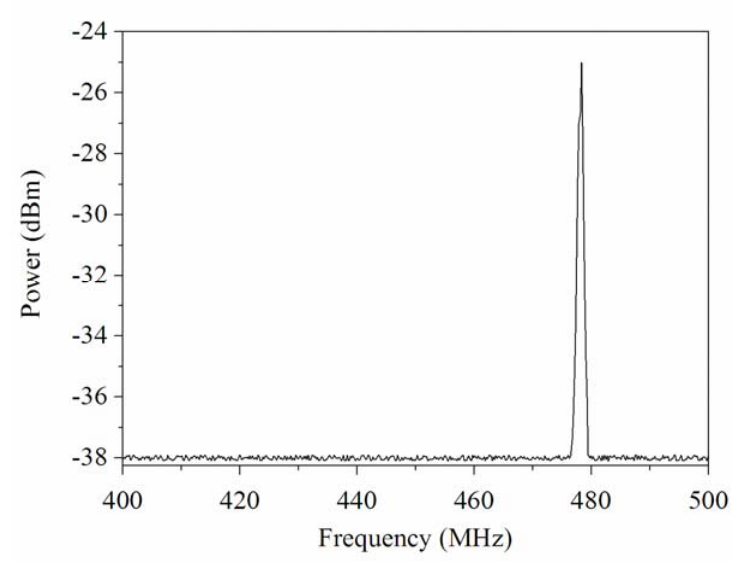
Figure 11. Frequency response of the pressure sensor at 400 kPa pressure.